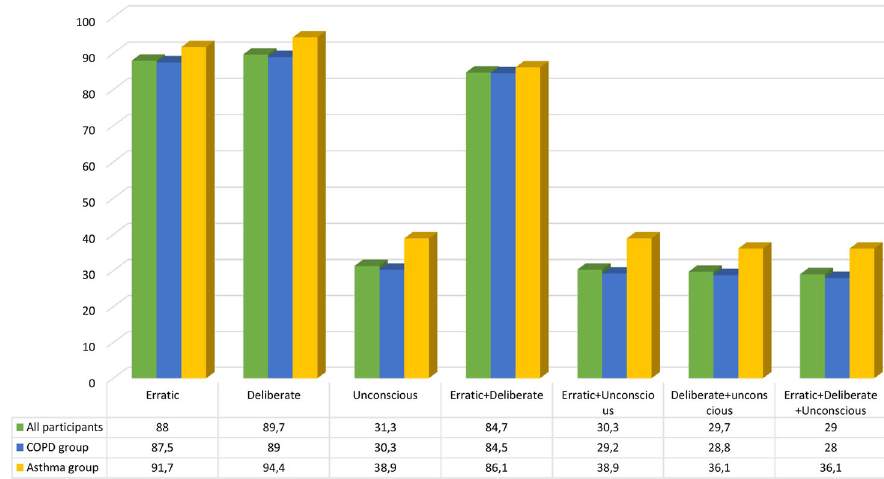
Fig. 1 Percentages of non-adherence behavior patterns in asthma and COPD patients (12-item TAI).